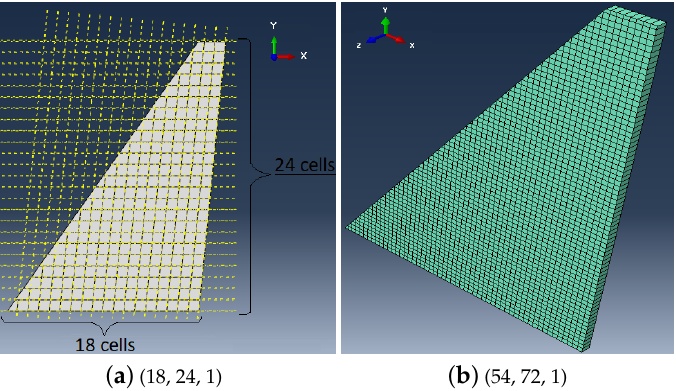
Figure 5. Design grid for the two considered meshes, where (X, Y, Z) denote the number of cells in x , y and z